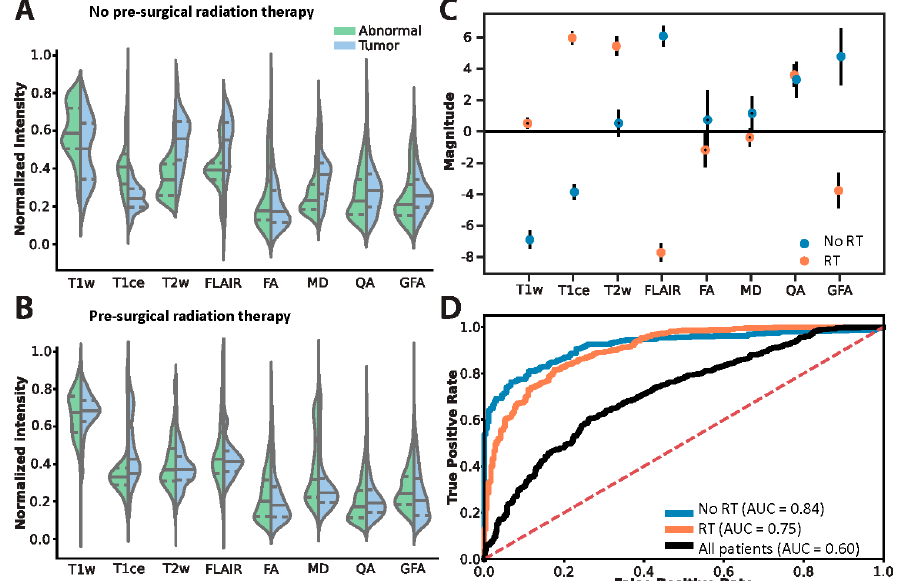
Figure 3. Differentiating the histopathology classifications Abnormal and Tumor on the voxel-level accounting for prior chemoradiation treatment regime. Voxel intensity histograms from the ( A ) No RT and ( B ) RT groups. Solid lines indicate median, dashed lines indicate the lower and upper interquartile interval. ( C ) Logistic regression coefficients: filled circles indicate significant features in the model, open circles indicate non-significant features. Error bars show standard deviation. ( D ) Logistic regression model performance using only the features deemed significant in ( C ). ROC denotes “receiver operator characteristics”, AUC denotes “area under curve”, and the “All patients” model (built only using features significant in both models) is an aggregate of the treatment